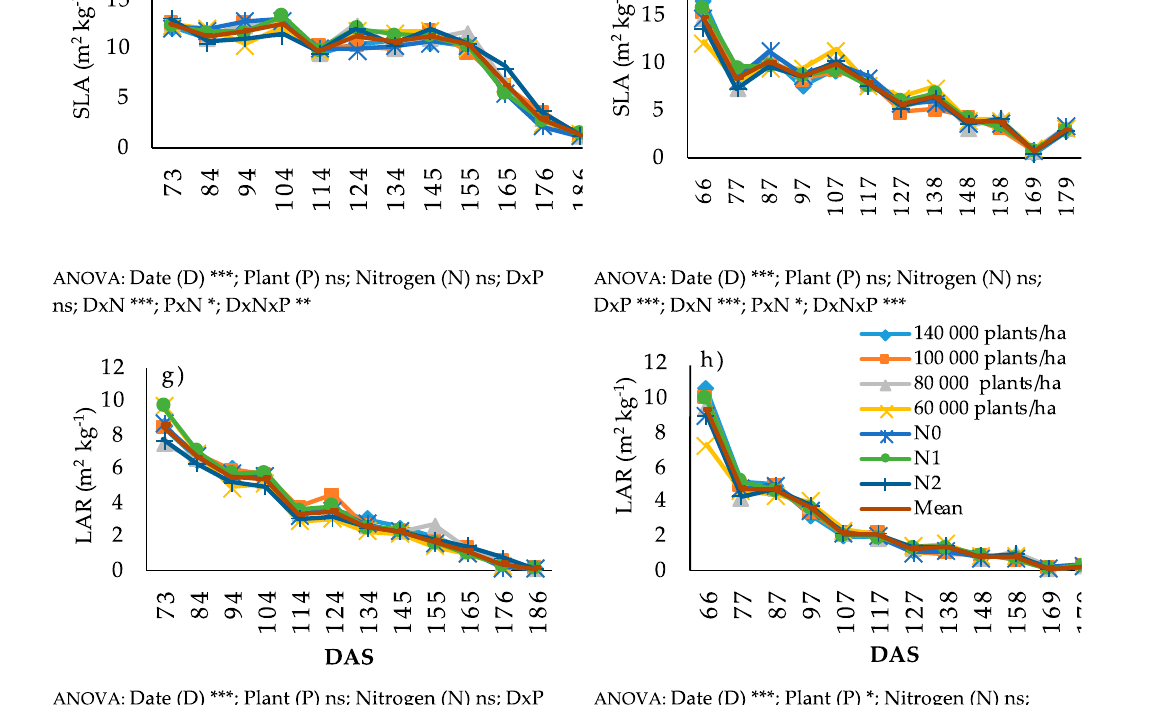
Figure 3. Changes of LA ( a , b ), LAI ( c , d ), SLA ( e , f ), and LAR ( g , h ) per plant during sugar beet vegetative growth as related to different plant densities (P) and nitrogen fertilization rate (N) in 2014 (on the left) and 2015 (on the right). The ANOVA results refer to LA, LAI, SLA, and LAR; the levels of significance were indicated with p < 0.05 (*), p < 0.01 (**), p < 0.001 (***) or ns for not